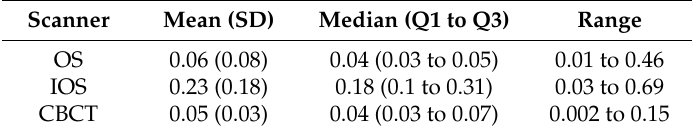
Table 2. Overall results for precision RMS values (mm) in different scanners. Scanner